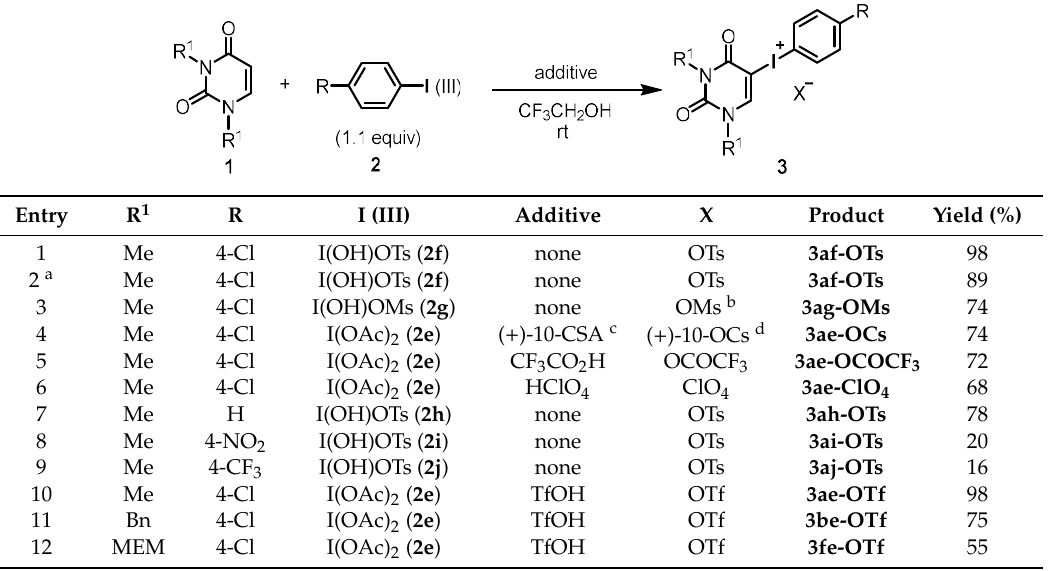
Molecules 2019 , 24 , x Table 2. Facile synthesis of uracil-iodonium(III) salts with various Table 2. Facile synthesis of uracil-iodonium(III) salts with various counterions.